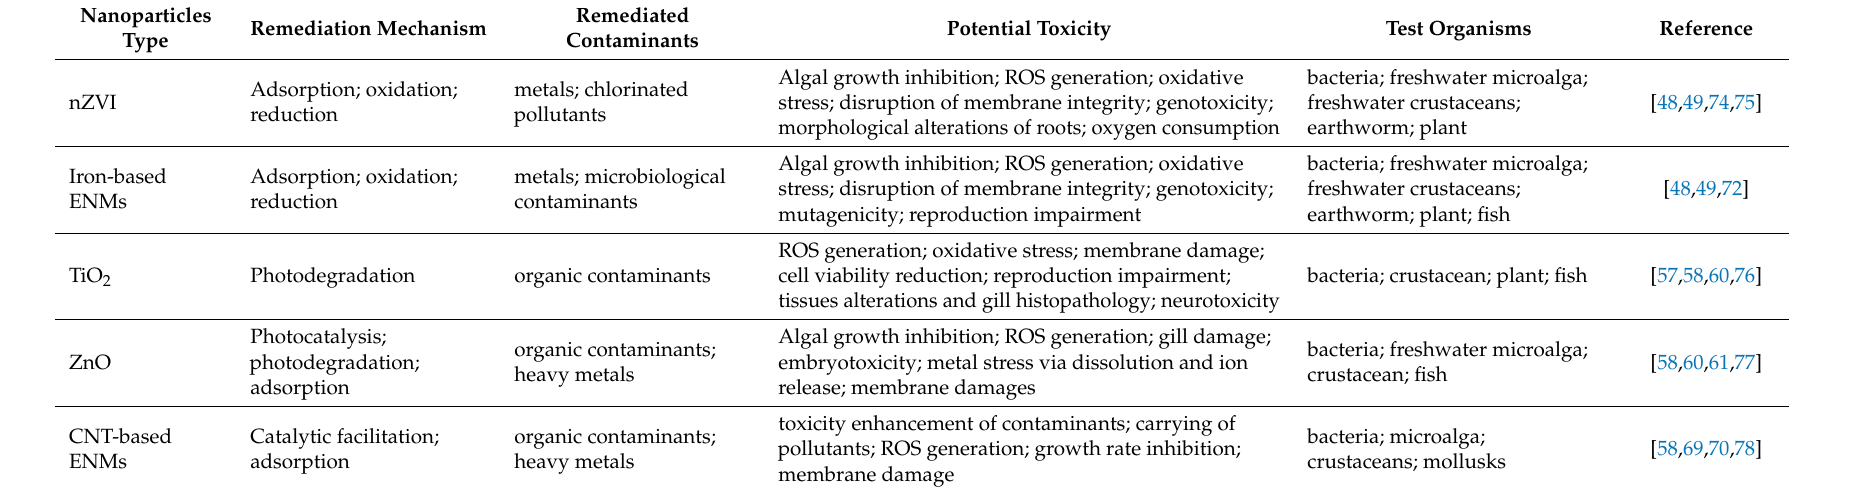
Table 1. Documented ecotoxicity of selected ENMs for environmental